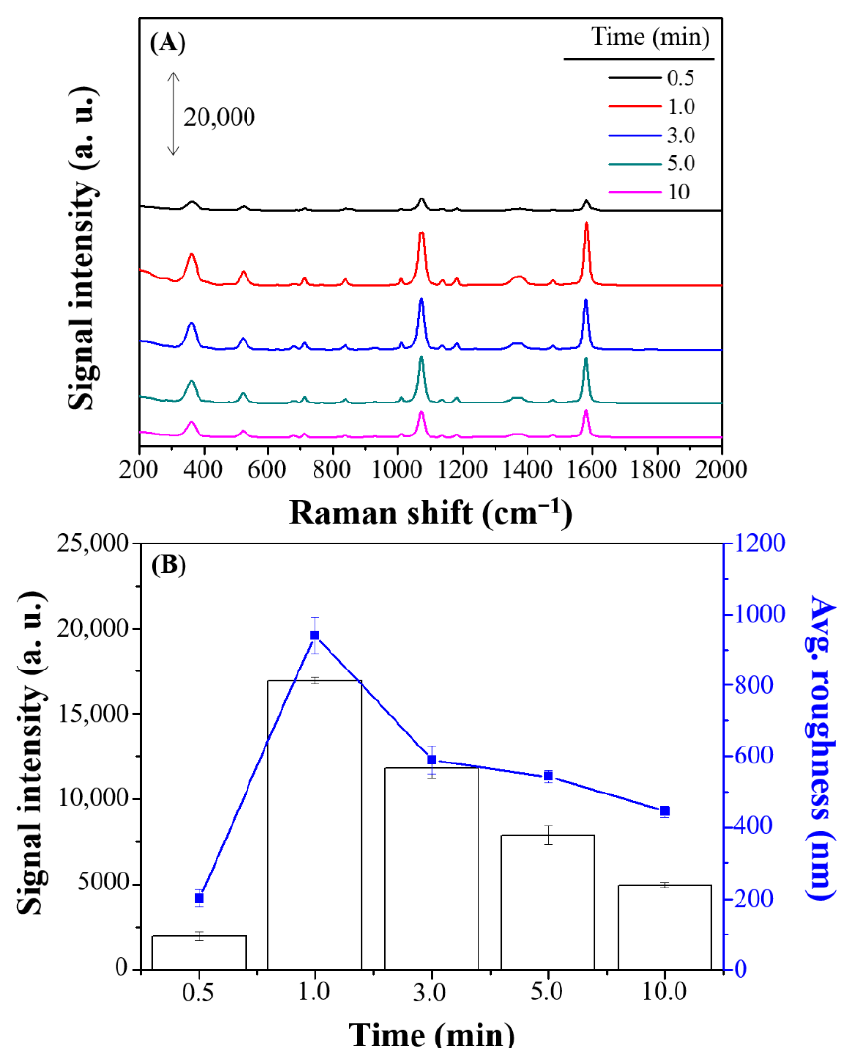
Figure 7. ( A ) SERS spectra and ( B ) Raman intensity and average roughness (nm) of 100 µM 4-MBA on Ag nanostructures prepared with various reaction times (0.5, 1.0, 3.0, 5.0, and 10 min). The error bars represent the standard deviations by using three batches of Ag substrates for which the average signal of 10 spots per sample are recorded.